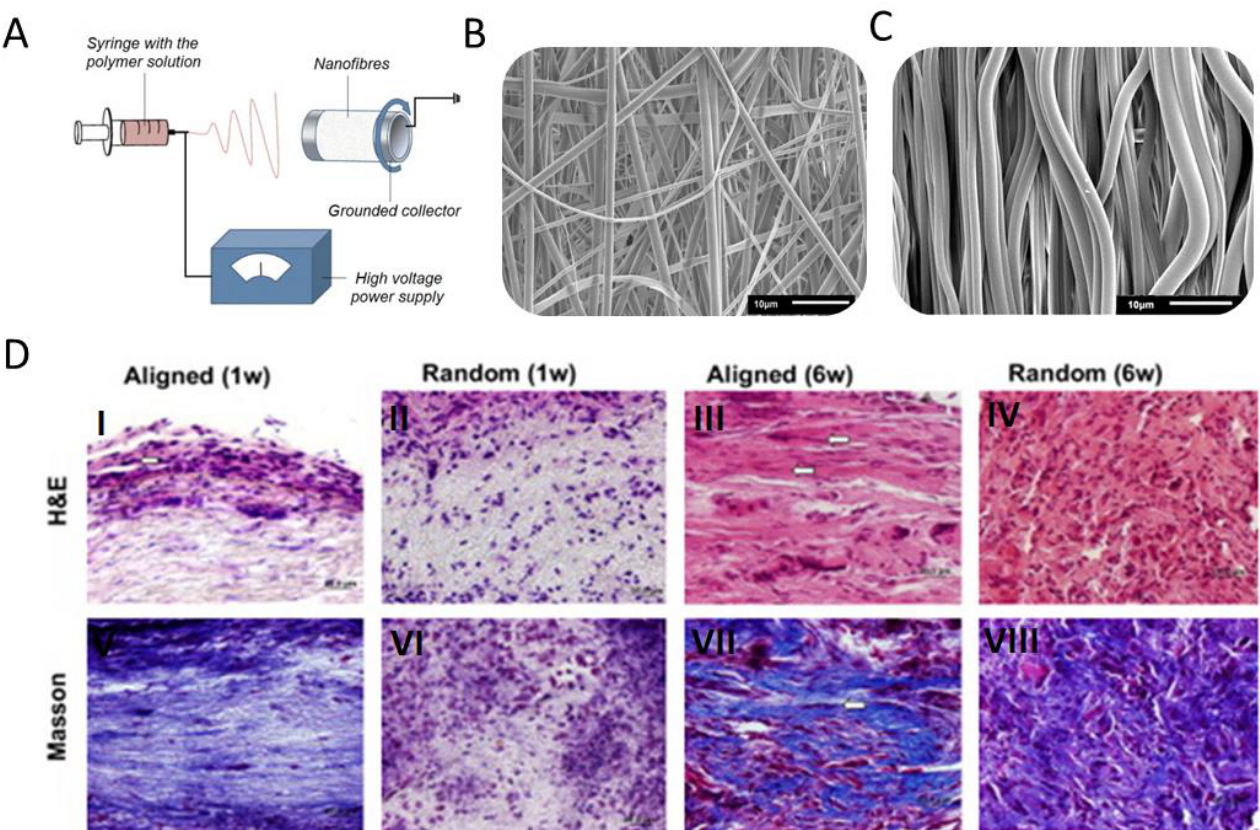
Figure 3. ( A ) Scheme of electrospinning setup; ( B ) SEM image of randomly distributed fibers obtained by electrospinning; ( C ) SEM image of aligned fibers obtained by electrospinning; ( D ) images showing the histological appearance of the cell orientation and matrix arrangement induced by electrospun nanofibers in vivo for 1 and 6 weeks ( I – IV —hematoxylin and eosin staining showing the histological appearance of fibrous scaffold-induced tissue formation; V – VIII —Masson’s trichrome staining of the bands of collagen fibers) [33]. (Figures cited under the license provided by Elsevier and Copyright Clearance Center, license number 5483771132131.)